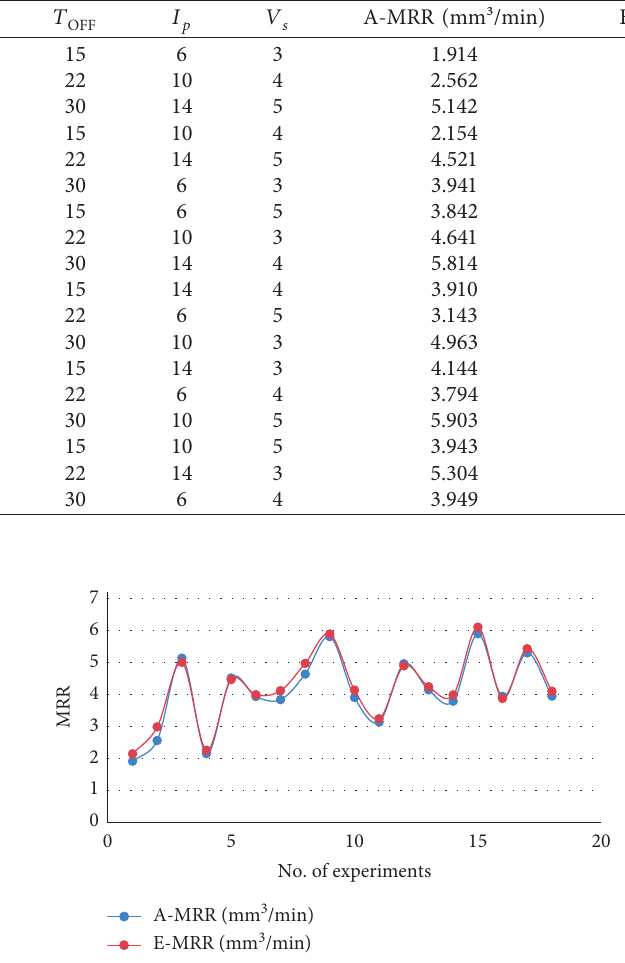
Figure 6: Performance comparison graph of A-MRR and